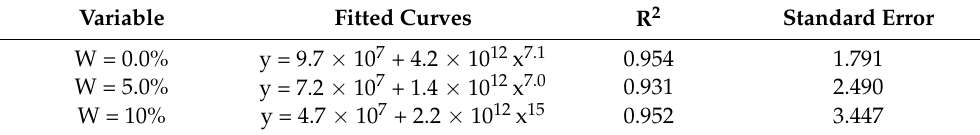
Table 1. Comparison of relative coal crushing rate and parameters fitted to permeability parameters.